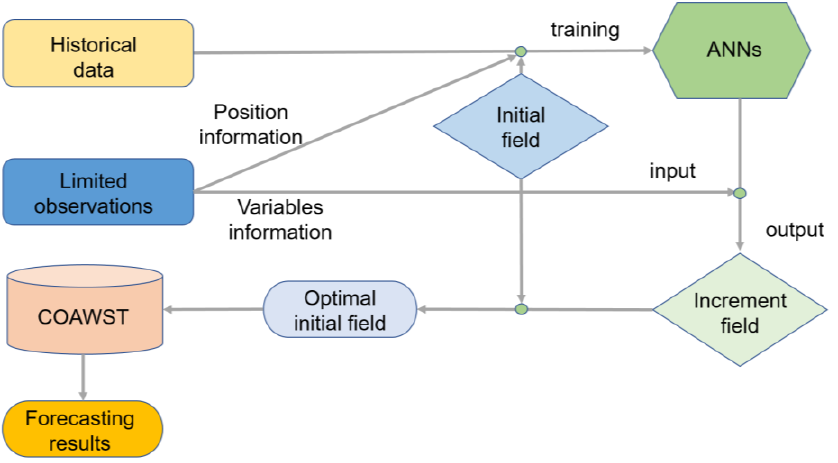
Figure 2. The implementation process of the IC algorithm.